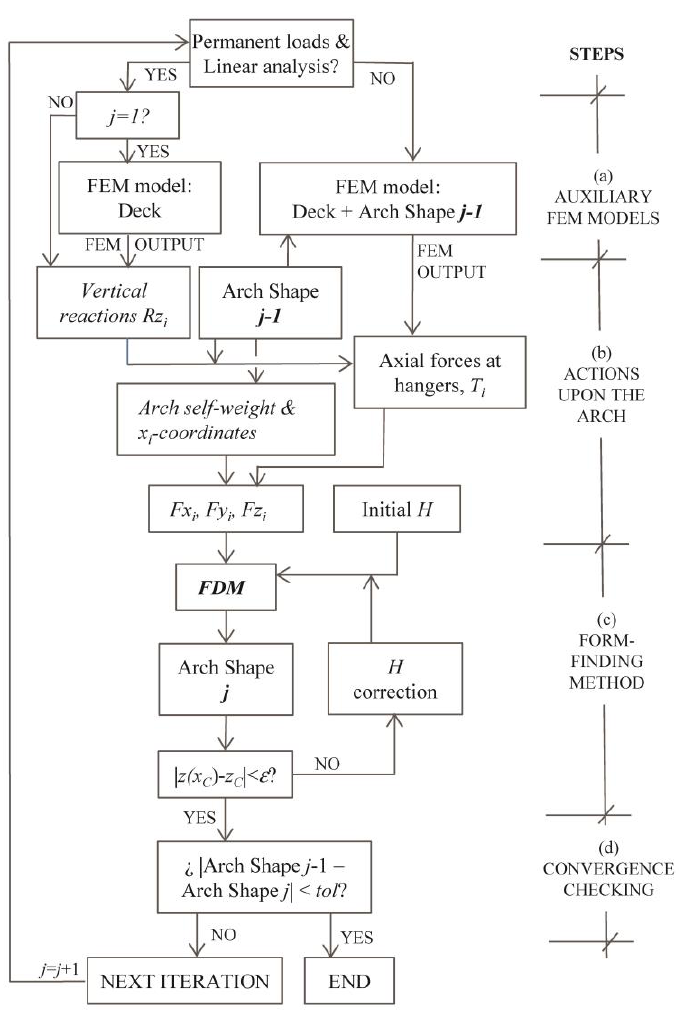
Figure 8. Simplified Forced Density Method: Flow chart.